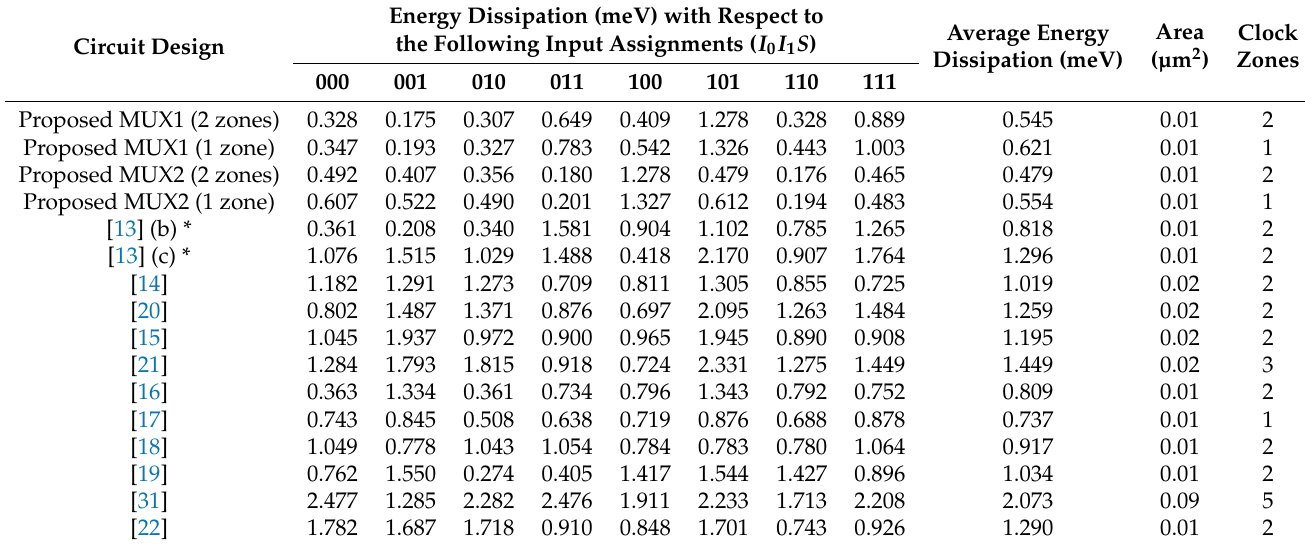
Table 3. Comparison of proposed 2 × 1 MUX with existing